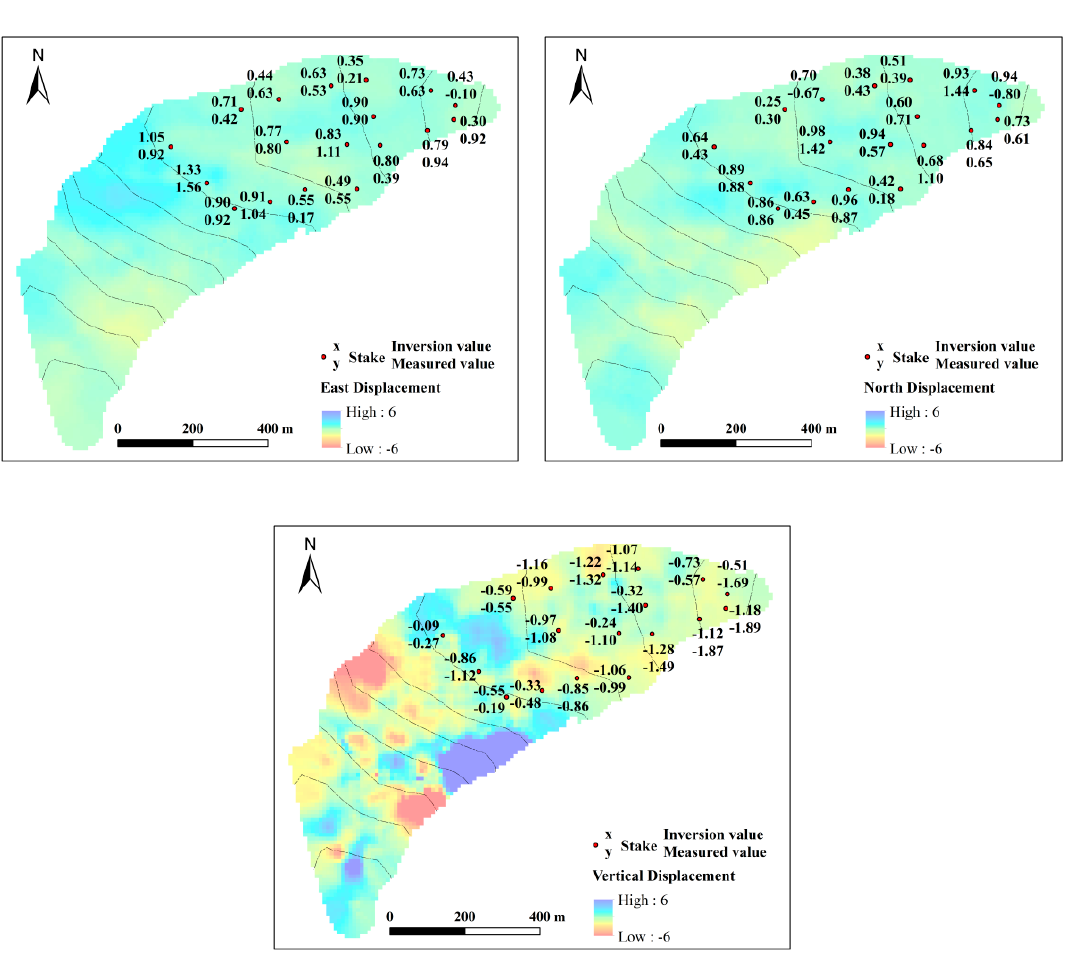
Figure 4. Displacement distribution of the east branch of No.1 Glacier in three directions (unit: m).